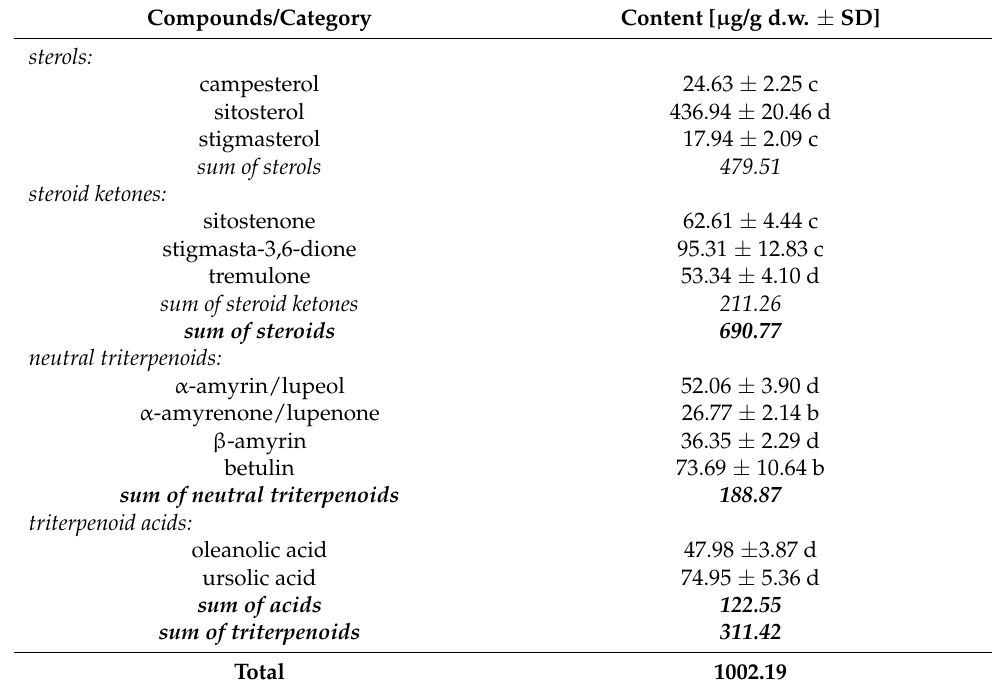
Table 3. Content of steroids and triterpenoids in Globularia alypum